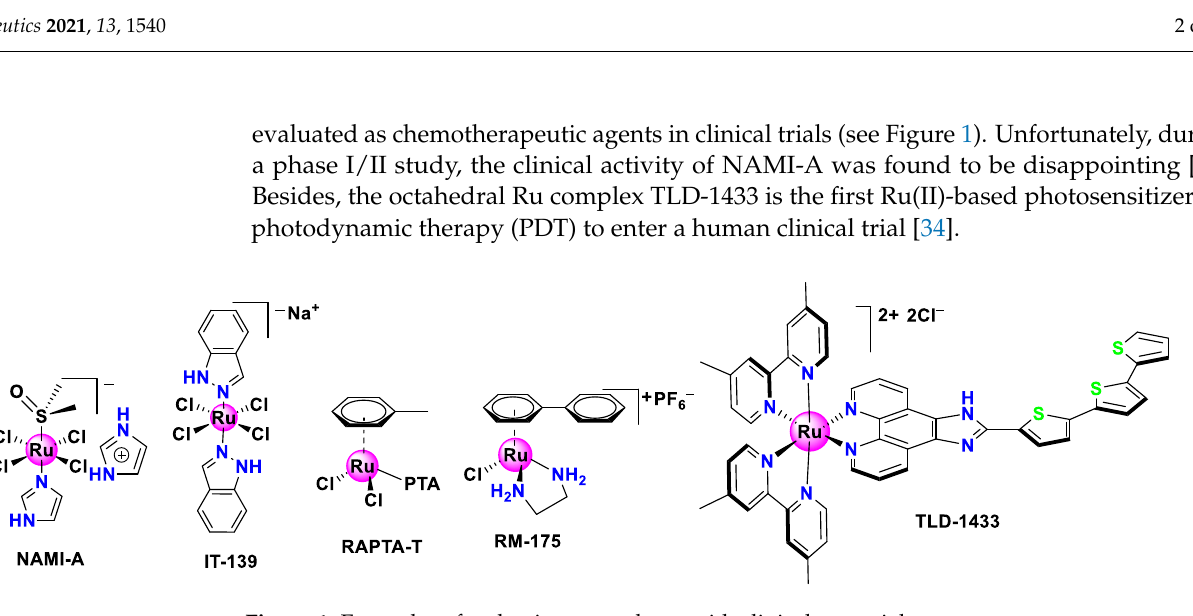
Figure 1. Examples of ruthenium complexes with clinical potential.